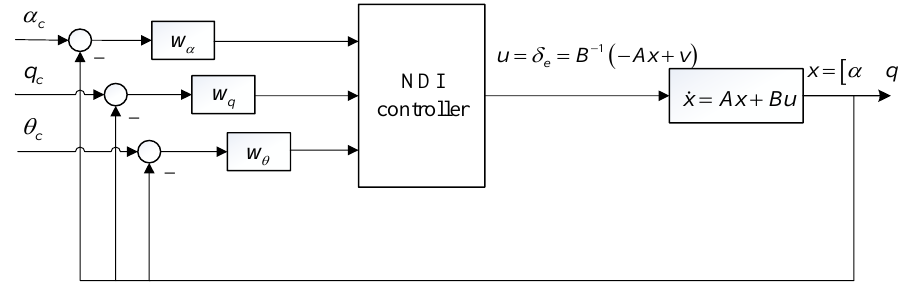
Figure 1. Longitudinal HFV nominal NDI control scheme.